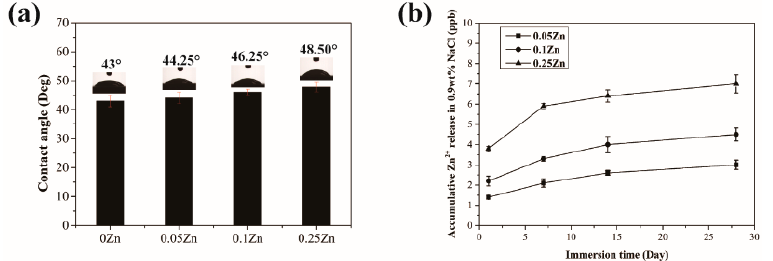
Figure 4. Contact angles of Zn-MAO coatings ( a ). The release of Zn 2+ from 0.05Zn-MAO, 0.1Zn, and 0.25Zn groups on 1, 7, 14, and 28 days ( b ).